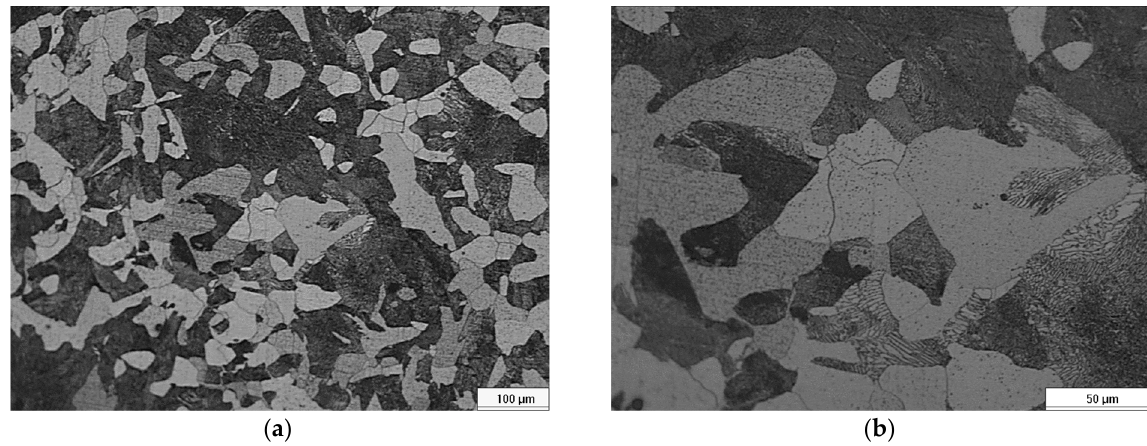
Figure 1. Microstructure of AISI 1045 at two magnification levels, ( a ) 100 µm and ( b ) 50 µm.